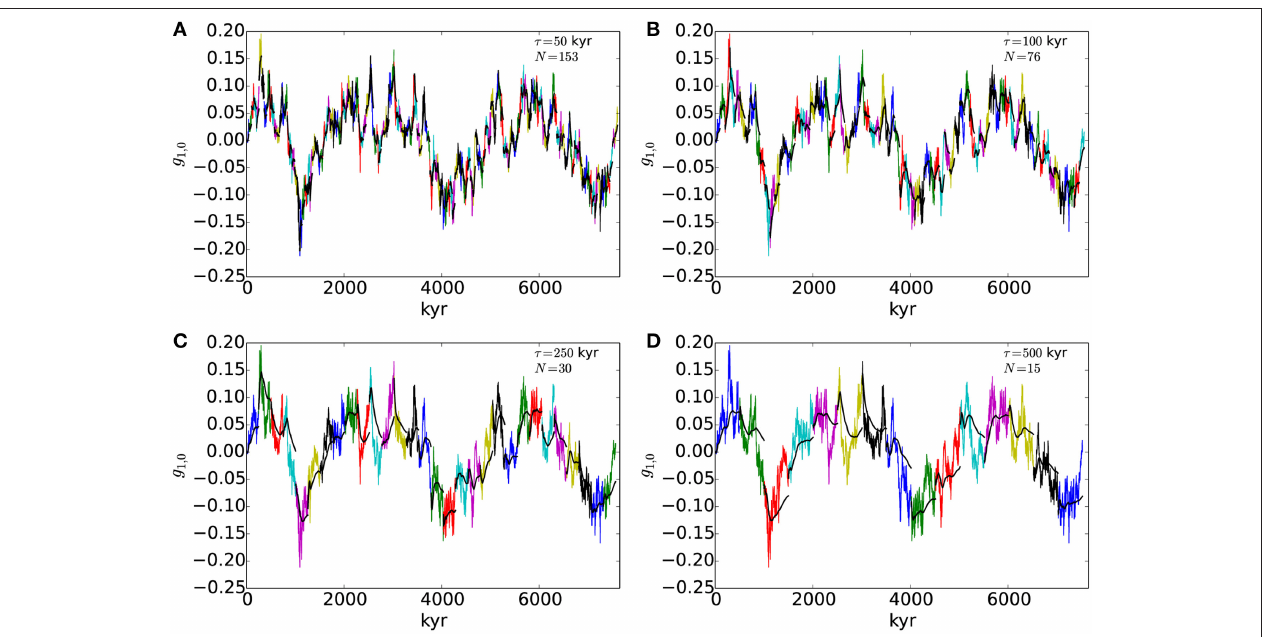
FIGURE 2 | Running average (black) of subsets (colors) of g 1,0 time series from model 4. Running average length of τ = 50 kyr (A) , τ = 100 kyr (B) , τ = 250 kyr (C) , and τ = 500 kyr (D) .